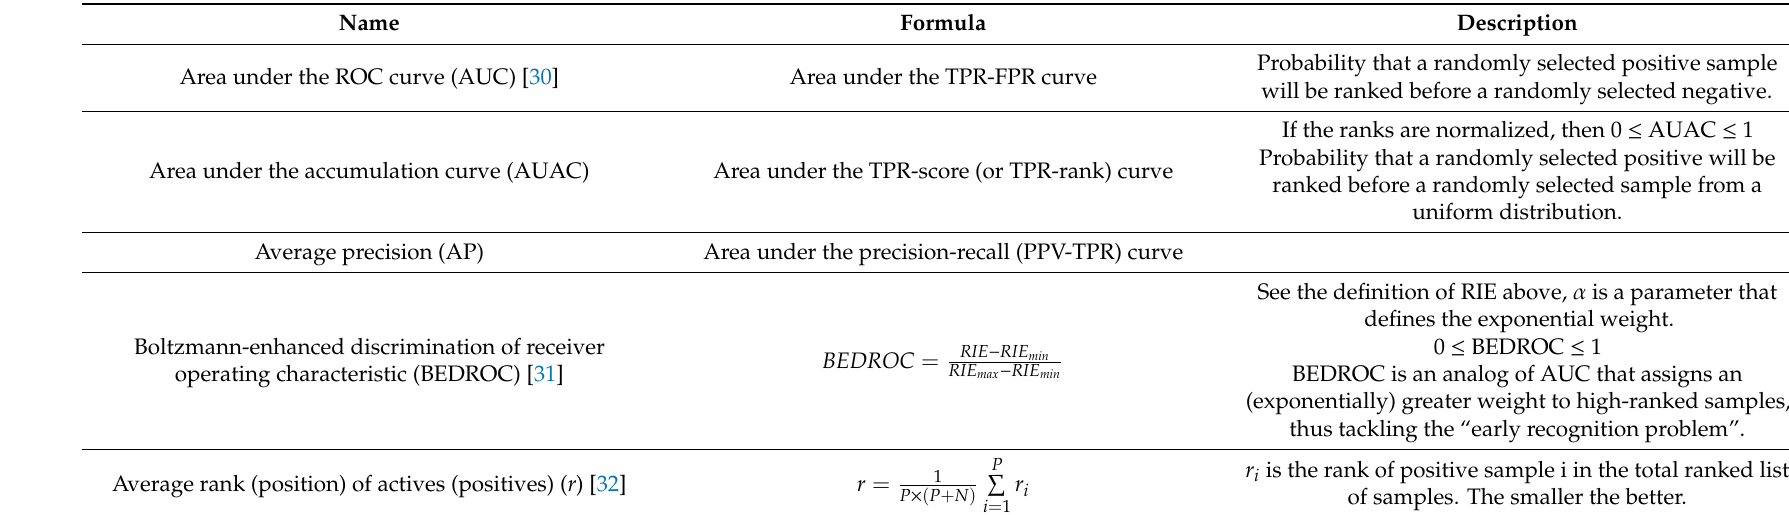
Table 6. Global performance metrics for 2-class